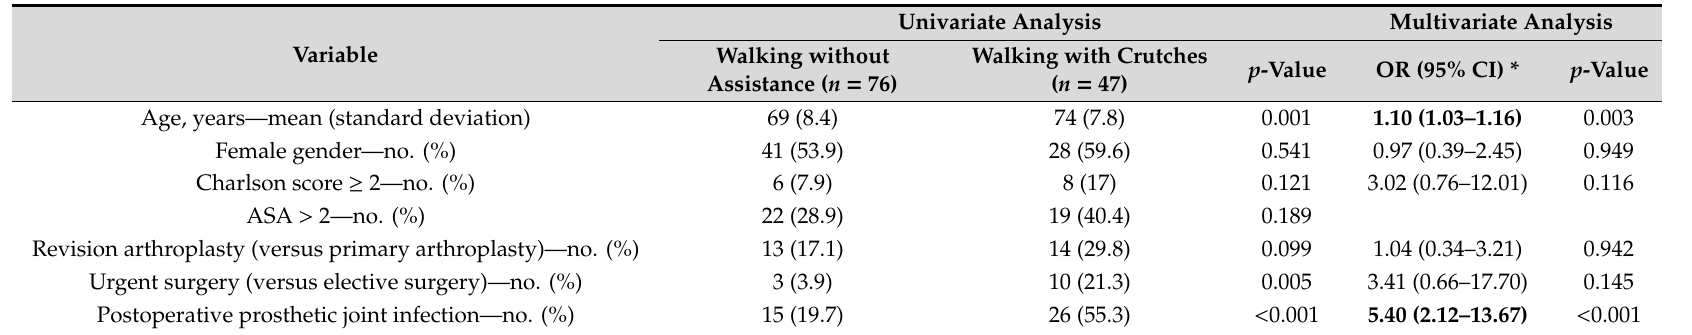
Table 4. Factors associated with requiring an assistive device for ambulation versus walking without assistance in 123 patients undergoing total hip replacements one year after the last surgical